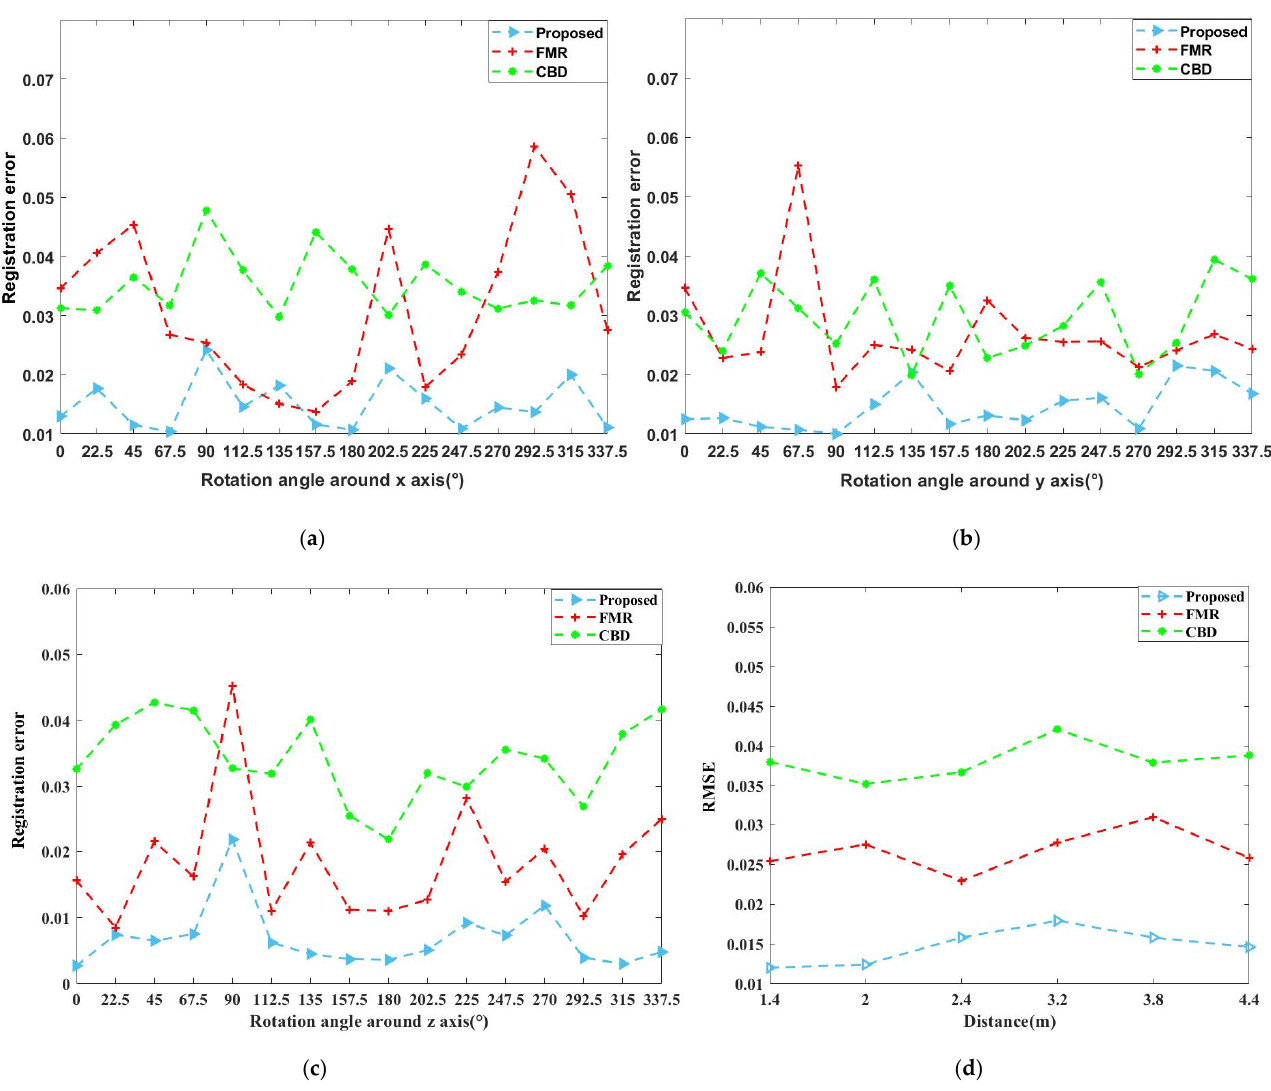
Figure 6. ( a – c ) When rotating around the x axis, y axis, and z axis, simulated point cloud fusion error for different rotation angles. ( d ) RMSE change curve for registration at different distances.